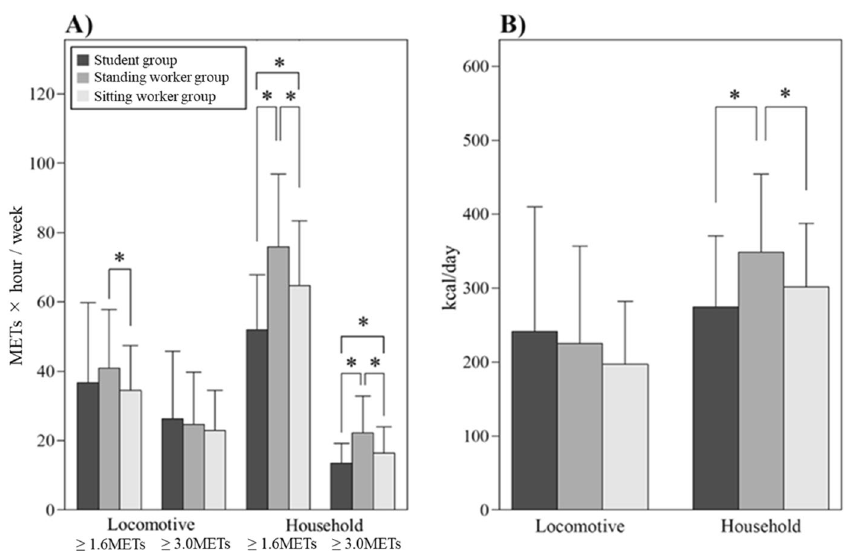
Figure 6. Magnitude of exercise (METs × hour) (A) and energy expenditure (B) of “Locomotive” and “Household” activities in the student, standing worker, and sitting worker groups. * p <